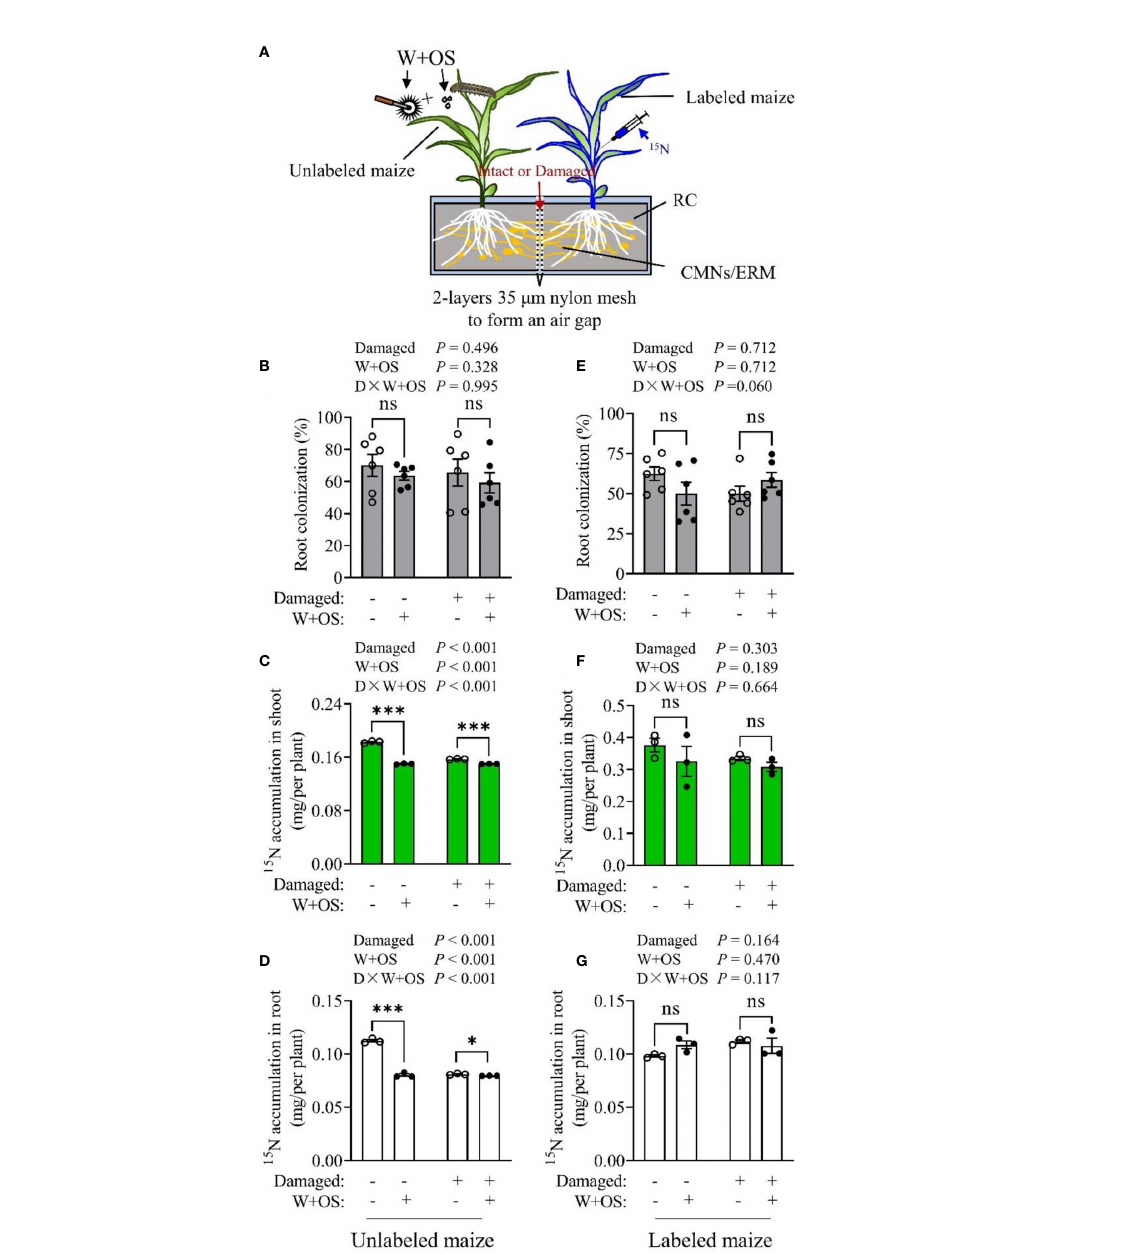
FIGURE 4 Common mycorrhizal network-mediated N transfer between maize plants was affected by herbivory. Maize plants were inoculated with Rir and cultivated in self-designed mesocosms as demonstrated in experiment IV (A) , RC, root compartment; CMNs, common mycorrhizal networks; ERM, extraradical mycorrhizal mycelia. The CMNs established between the two maize plants were either damaged daily or intact. Five weeks after Rir inoculation the mycorrhizal colonization rate in the roots was measured (B, E) . Thereafter, 10 days after 15 N labeling and W+OS treatment, 15 N was detected in unlabeled plants (C, D) and 15 N-labeled plants (F, G) . Data are the means ± SE of the three (or six) biological replicates. Asterisks indicate signi fi cant differences (Student ’ s t-test, * P < 0.05; *** P < 0.001; ns, no signi fi